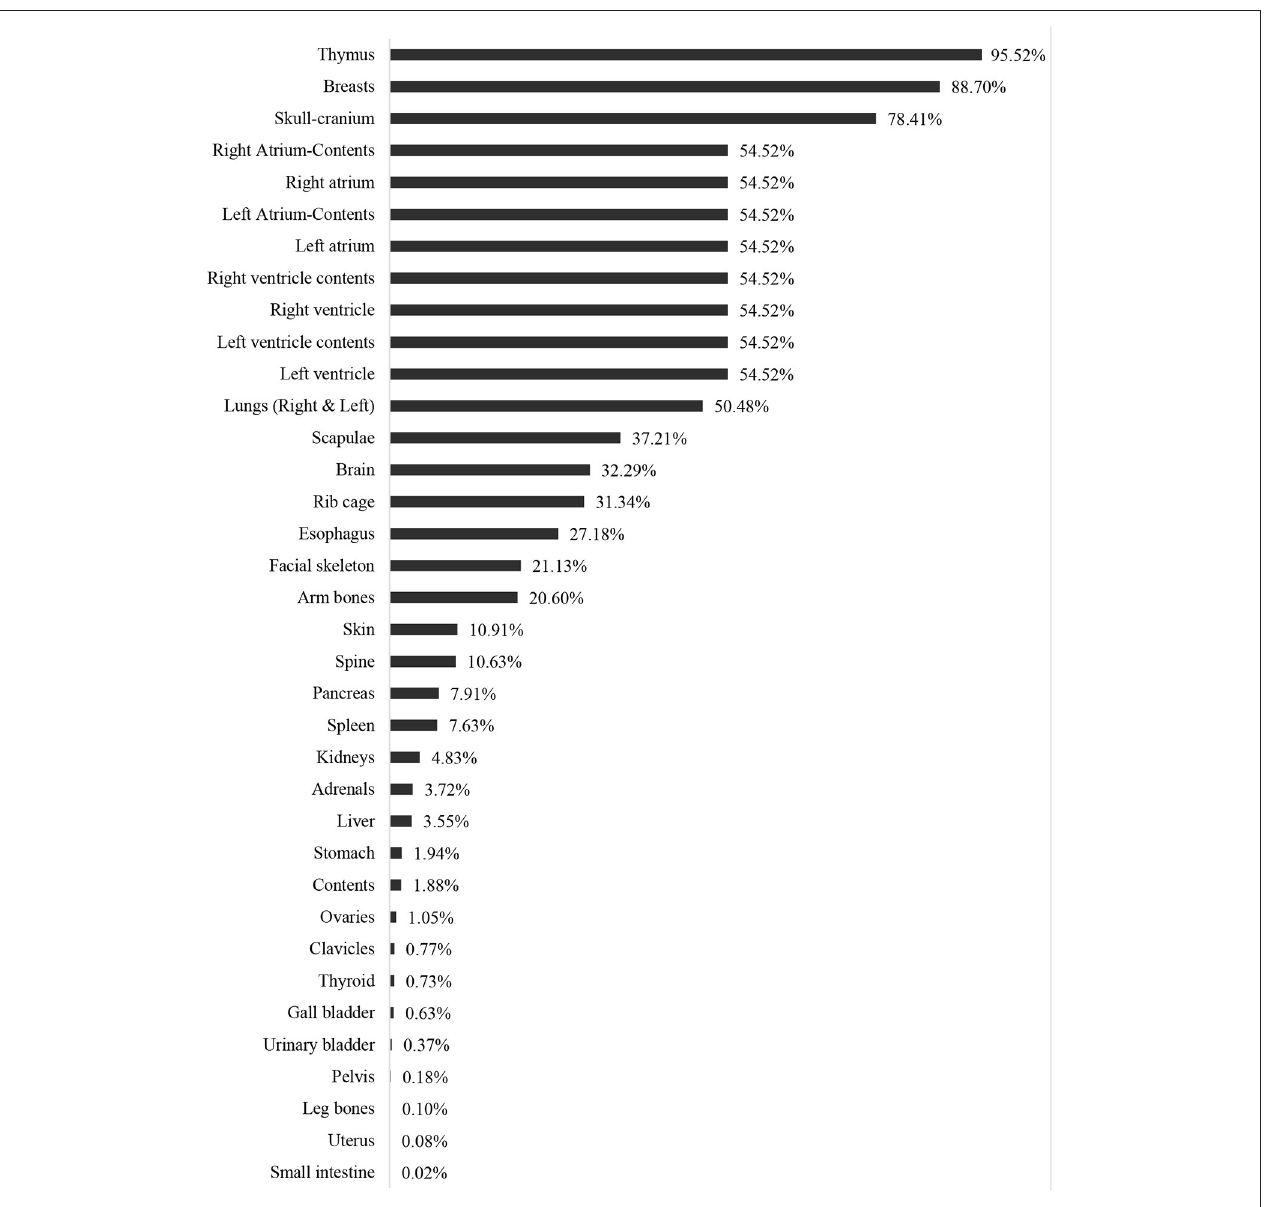
FIGURE 6 | The reduction percentages (%) of the absorbed radiation doses in organs and